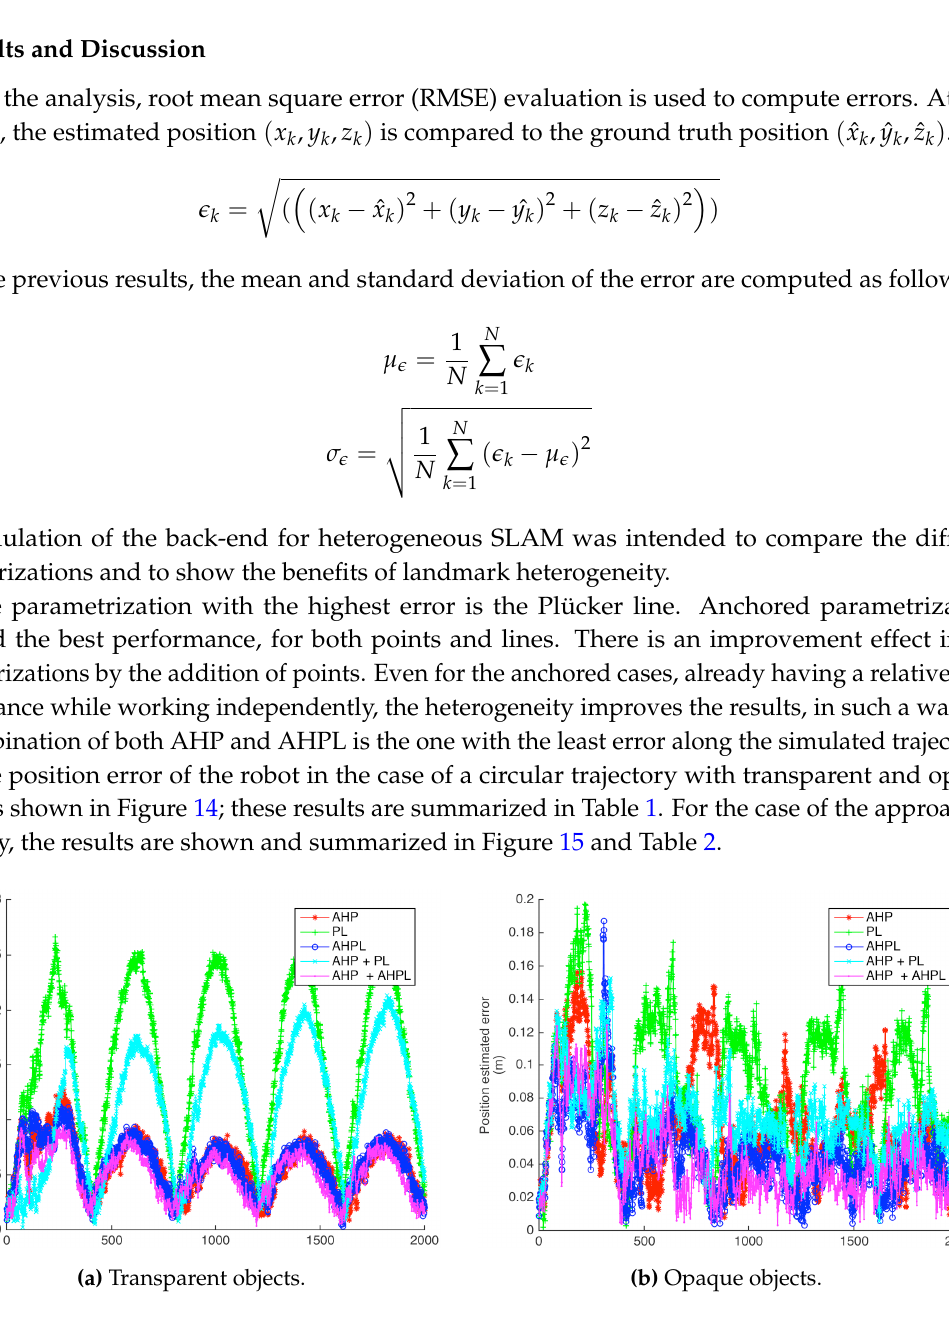
Figure 14. Robot position estimation errors for the circular trajectory. Table 1. Robot position error mean and standard deviation, for transparent and opaque object visualization, for the different heterogeneous landmark parametrizations in the circular trajectory in the simulated